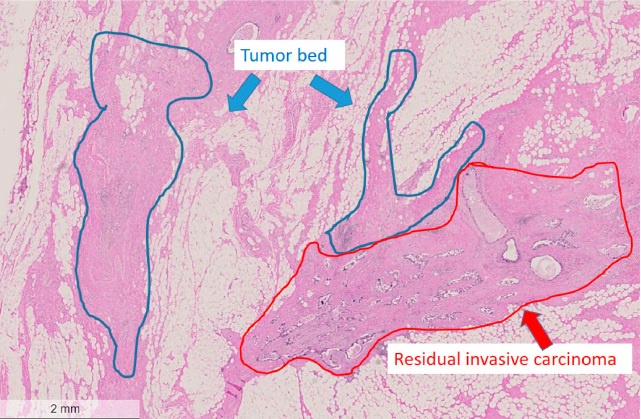
Figure 2. Areas marked for microdissection (tumor bed region circled with blue, residual tumor area circled with red). Hematoxylin and eosin (H&E) stain, bar: 2 mm.